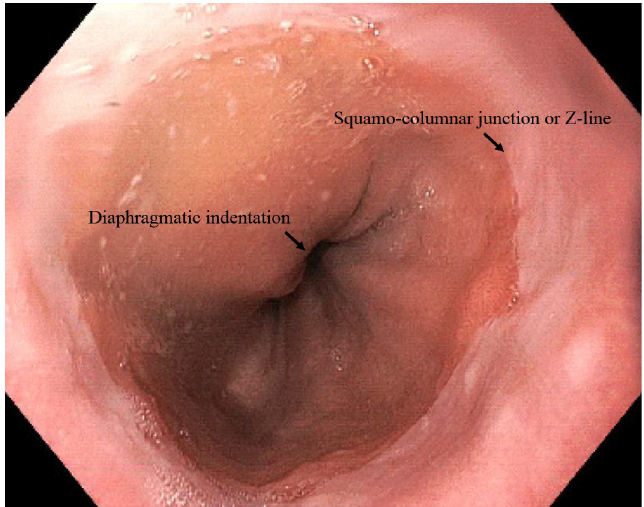
Fig 1. Endoscopic diagnosis of a hiatus hernia. Hiatal hernia diagnosis is made based on the presence of a diaphragmatic indentation of at least 2 cm distal to the squamo-columnar junction or Z-line.